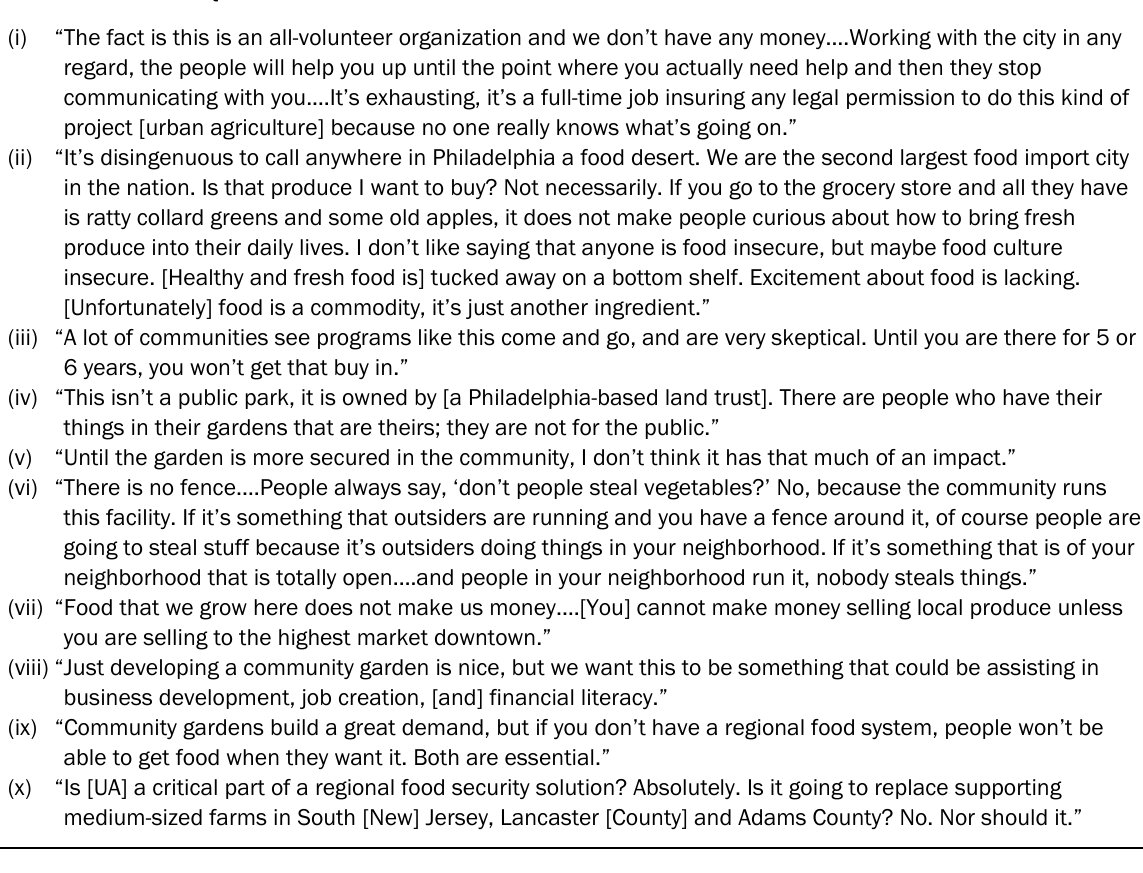
Table 1. Selected Quotes from